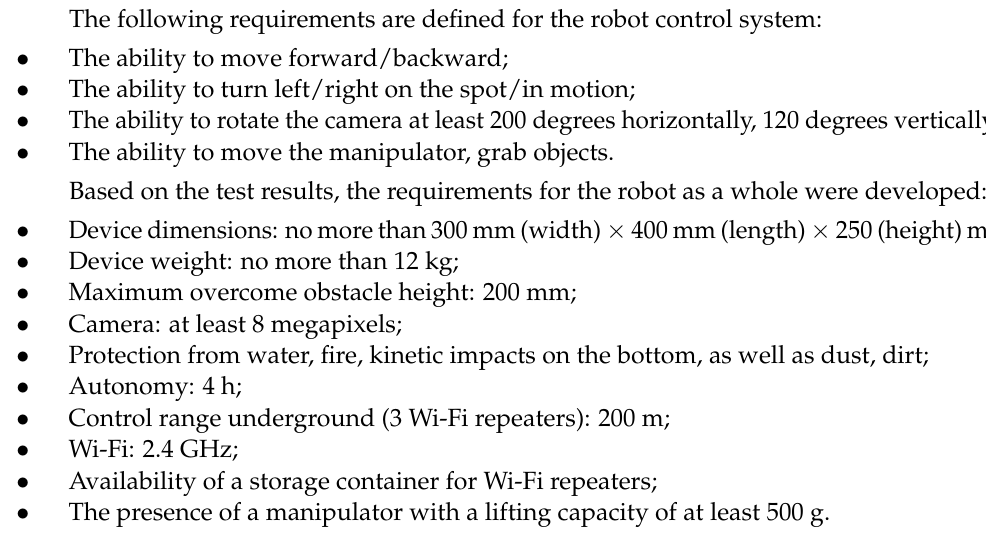
Figure 11. Mapping tests result. Operator’s smartphone screenshot. (Colormap: blue—top, green— sides, black—bottom,